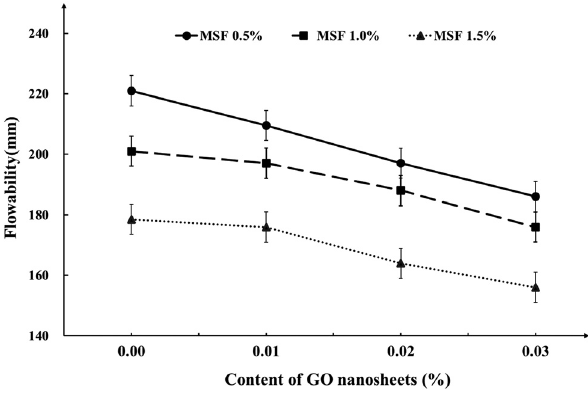
Figure 4: Flowability of fresh mixtures.